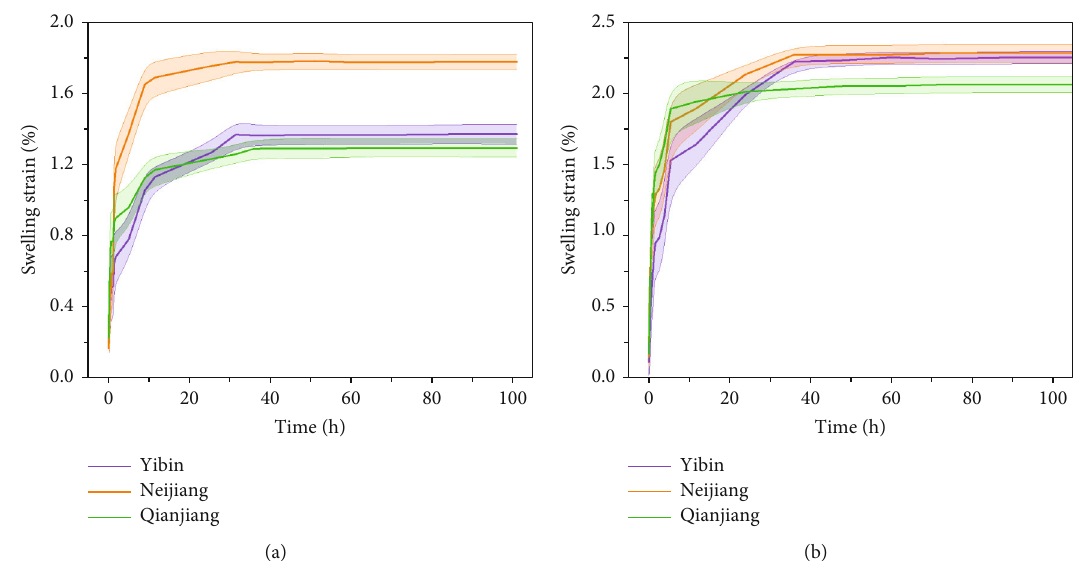
Figure 7: Swelling performance of mudstone immersed in water: (a) undistributed sample and (b) natural air-dried